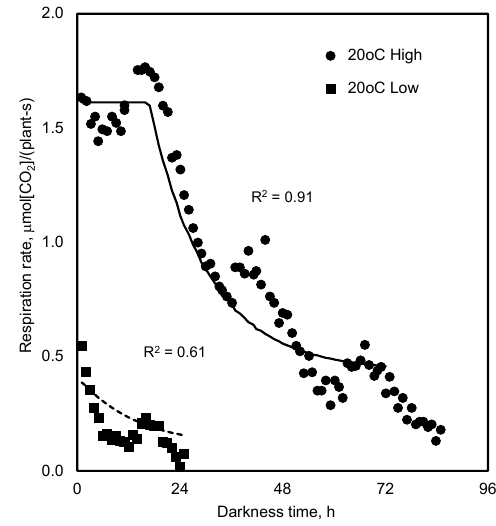
Figure 2. Respiration rate of whole tomato plants in prolonged darkness after pre ‐ treatment under high or low light of 1000 or 200 µ mol[PAR]m − 2 s − 1 [14]. Filled symbols are measured values for high and low light, and lines are predictions of the dynamic model. The R 2 is given for each time series.